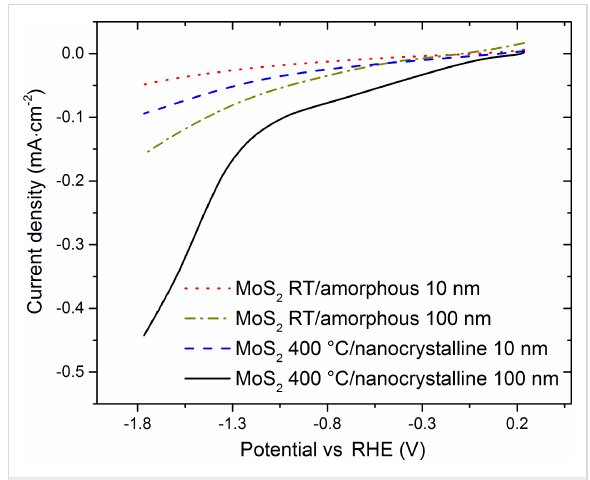
Figure 6: Electrochemical HER measurements on our PVD MoS 2 films directly on SiO 2 covered Si substrates.